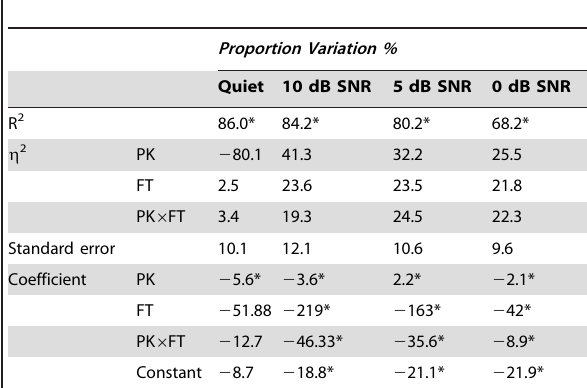
Table 2. Summary of Multivariate Regression